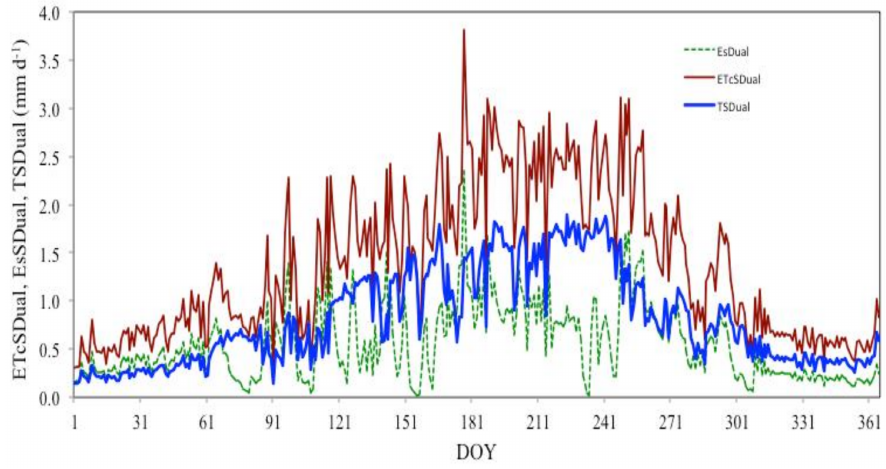
Figure 4. Crop evapotranspiration ( ET cSDual ), transpiration ( T SDual ), and soil evaporation ( E sSDual ) modeled with SIMDualKc for 2014.